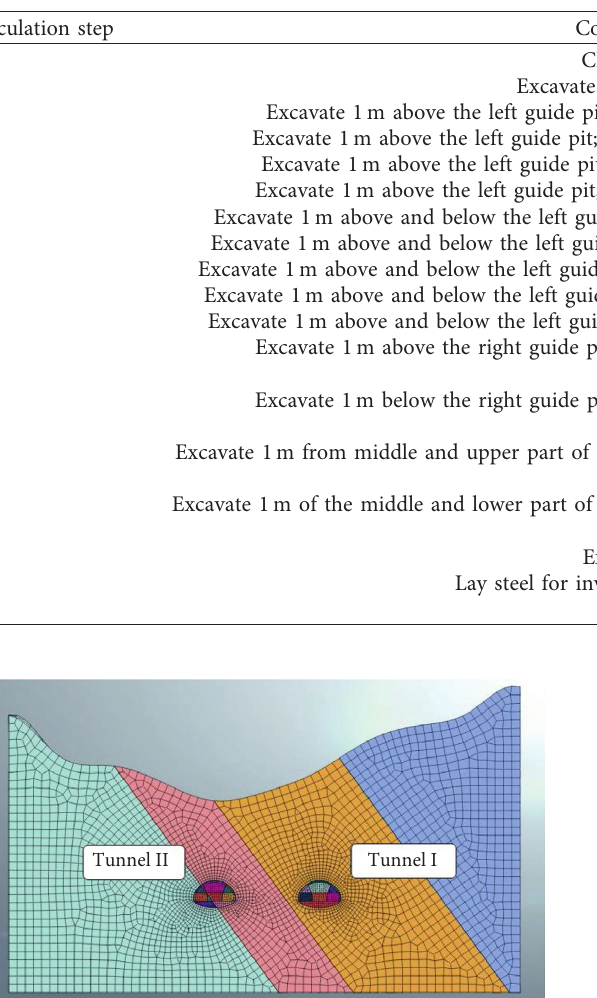
Table 3: Main calculation steps for the construction of the double-side guide pit method.